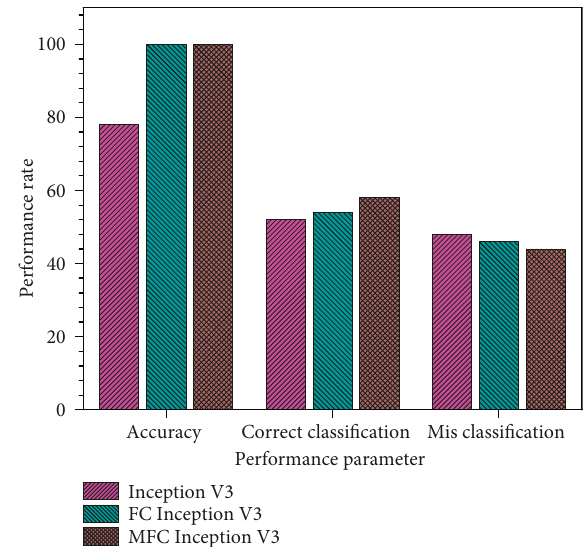
Figure 5: Comparison of L1-IRC model with existing models for different sizes of training samples.